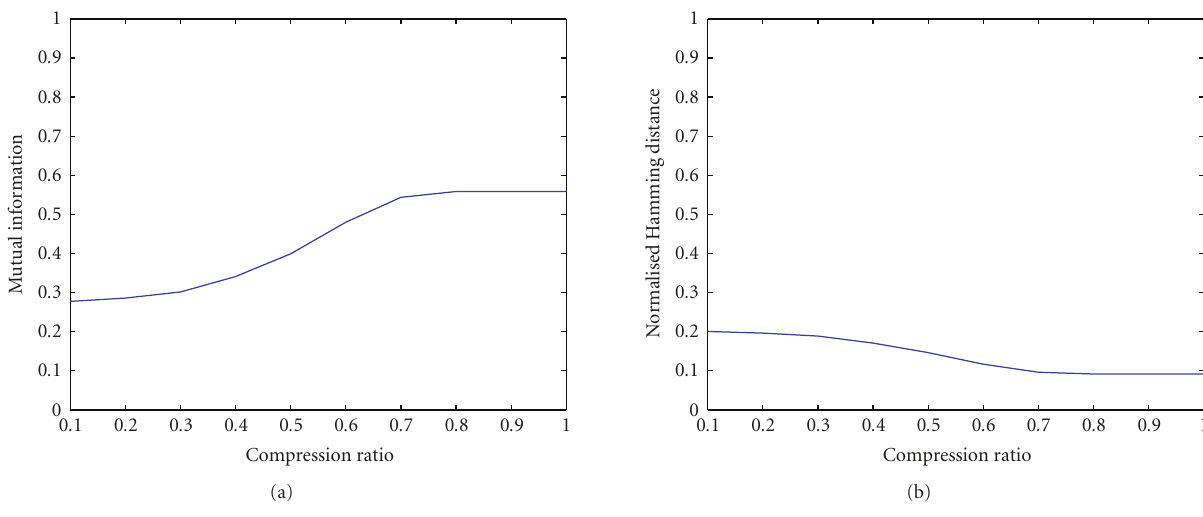
Figure 14: Detector response to JPEG2000 compression attack: (a) mutual information; (b) normalized Hamming